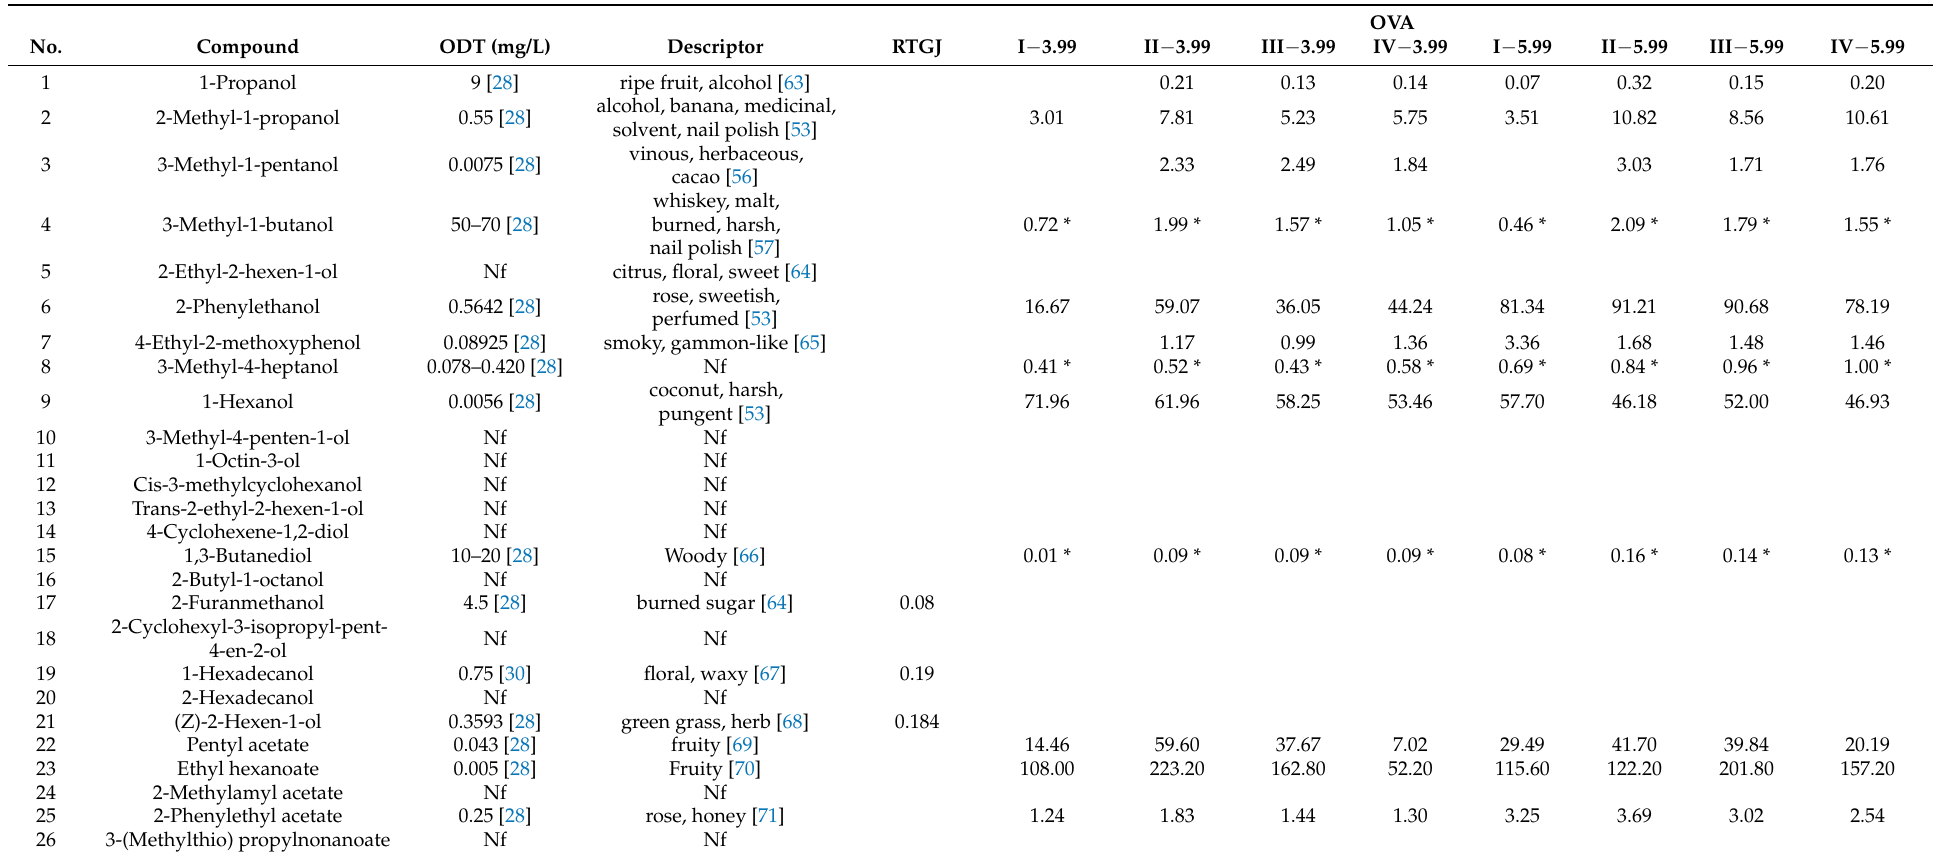
Table 7. Odor Activity Values (OAV) and Odor Detection Thresholds (ODT) of the Volatile Organic Compounds Detected in the Nonfermented Red Table Grape Juice (RTGJ) and in Different Kefir-like Beverages Obtained from the Four Subcultures in Fed-batch Fermentations A (I − 3.99, II − 3.99, III − 3.99 and IV − 3.99) and B (I − 5.99, II − 5.99, III − 5.99 and IV − 5.99).